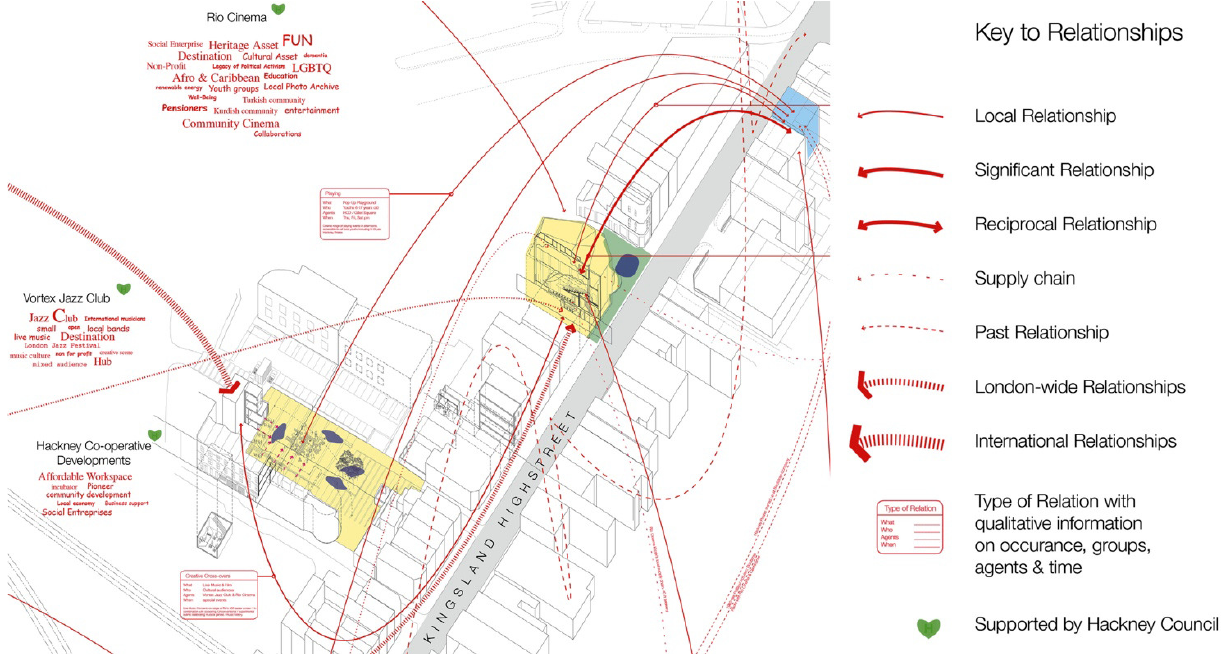
Figure 6. Detailed extract of RSD map showing labels with stakeholder information, including council subsidies, together with key to different types of relationships. Areas shown: Gillett Square and Kingsland High Street. Source: Courtesy of Unit A research